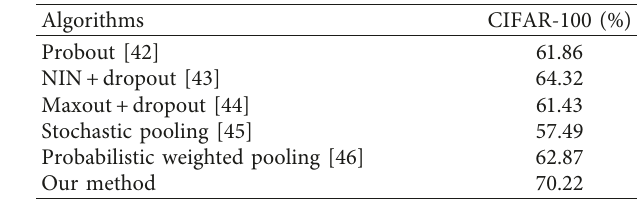
Table 3: Experimental results on CIFAR-100 before and after using full stage data augmentation method.